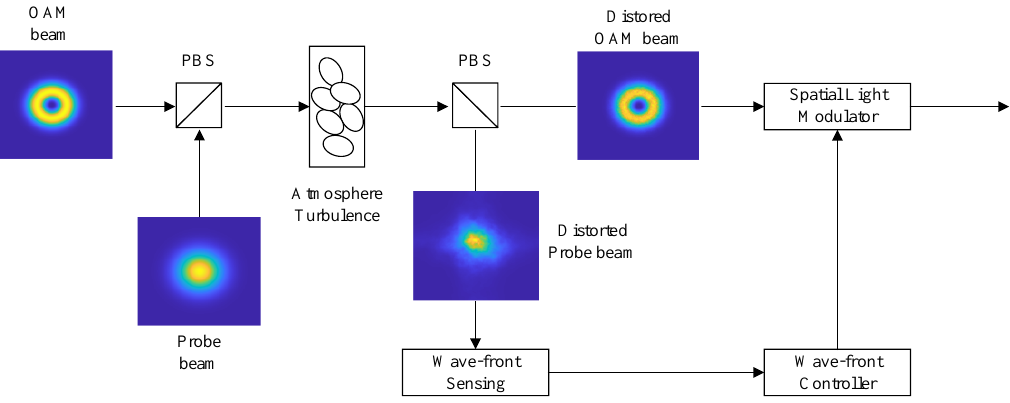
Figure 1. Schematic diagram of the OAM-FSO system based on AO.